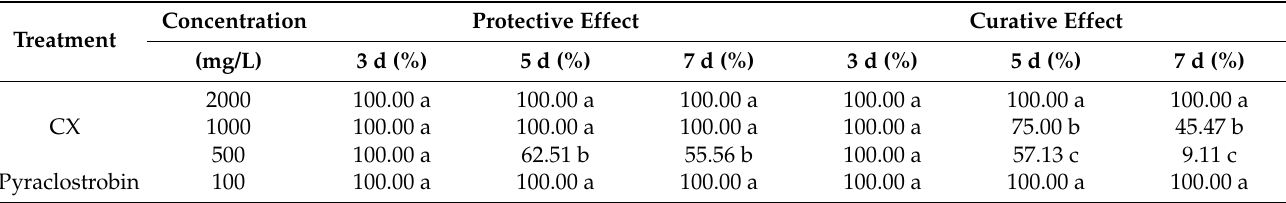
Table 4. In vivo control effect of CX plant extracts on Botrytis cinerea